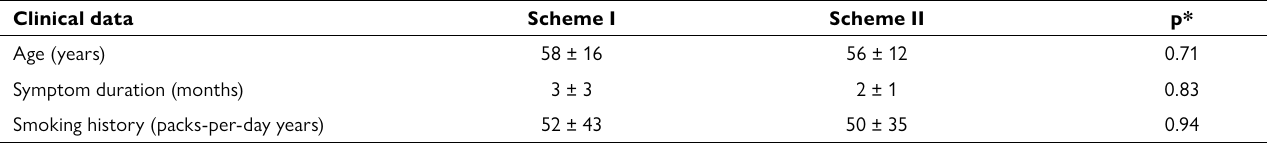
Table 1 Comparison of clinical data from TB patients who were treated with Scheme I or Scheme II. The data are expressed as mean ± standard deviation showing significant similarities between the used patient